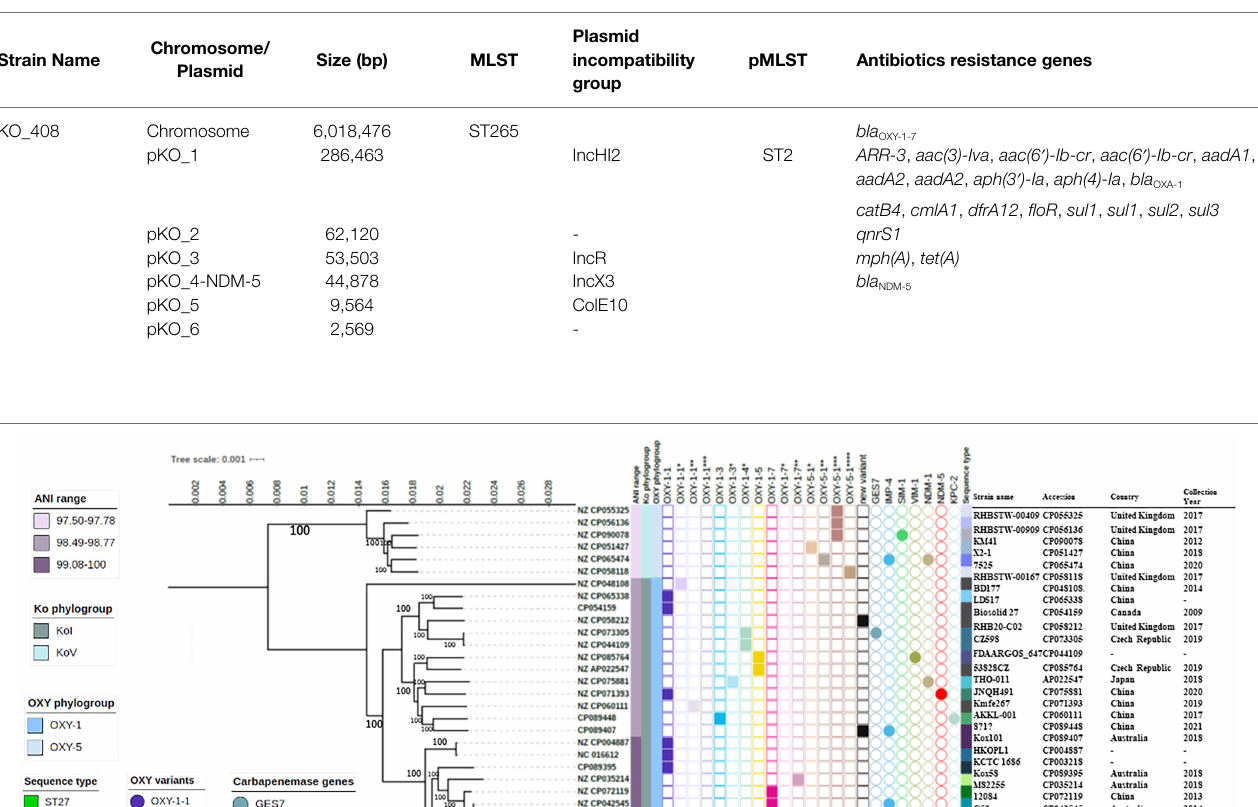
TABLE 2 | Chromosome and plasmid features of KO_408 strain.